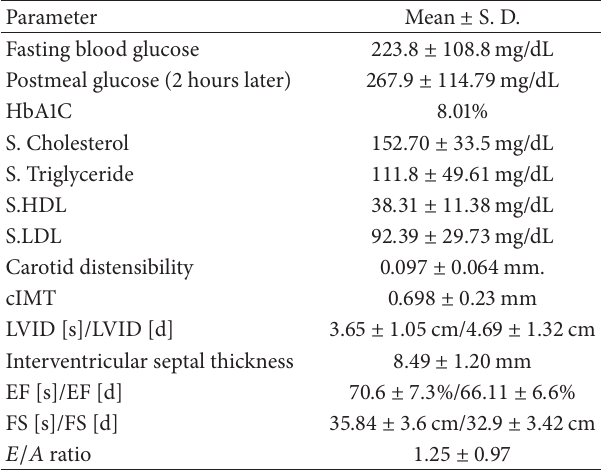
Table 1: Mean laboratory and echocardiographic parameters of study